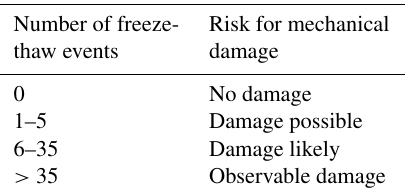
Table 2. Risk for mechanical damage of the masonry wall based on the number of freeze-thaw